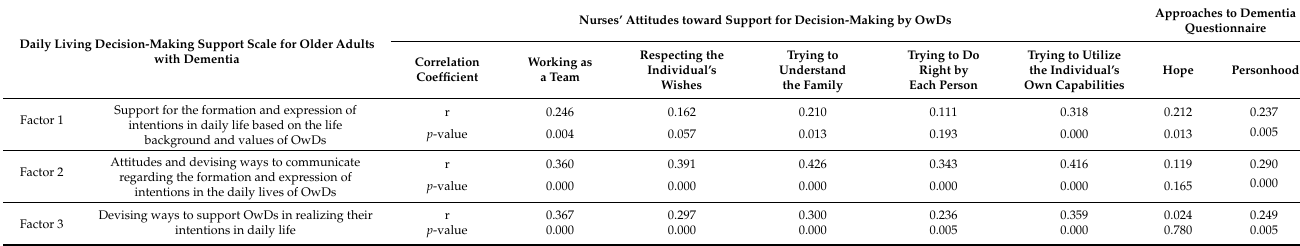
Table 4. Correlations between the Daily Living Decision-Making Support Scale for Older Adults with Dementia and the evaluation